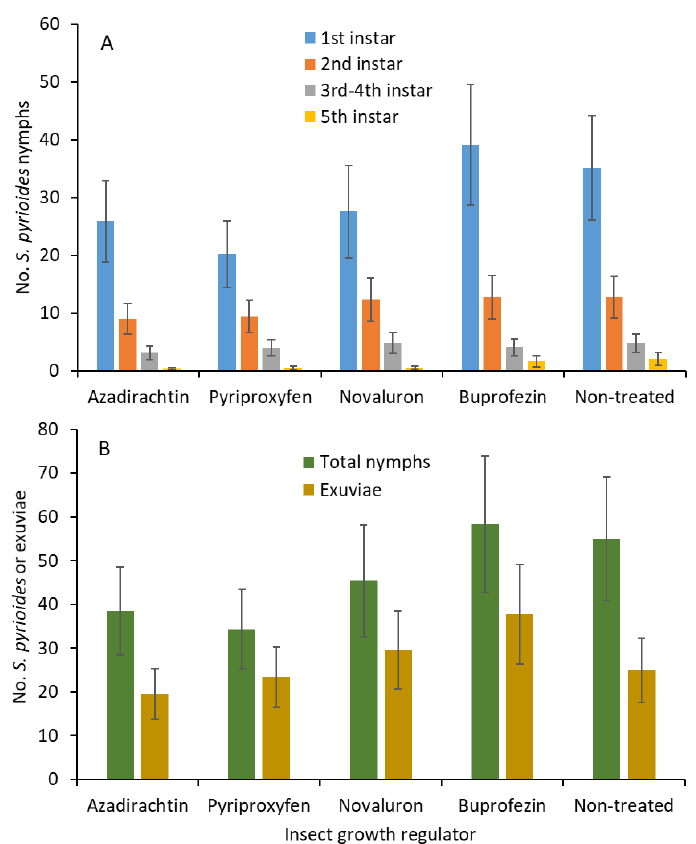
Figure 2. Least squares mean ( ± SE) numbers of various instars from S. pyrioides in ( A ) the first, second, third and fourth, and fifth instars and ( B ) the total nymphs and exuviae at 7 d posttreatment when IGRs without adjuvant were painted onto the adaxial surfaces of the leaves after S. pyrioides eggs were implanted. Bars of the same fill color with the same letters are not significantly different (pairwise t- test, p = 0.05). Nonsignificant data have no letters.